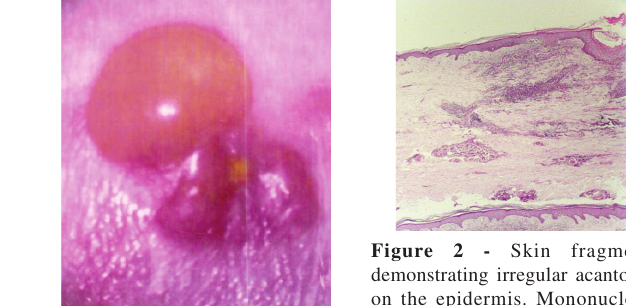
Figure 4 - Detail of the inflammatory infiltrate around the skin blood vessels.